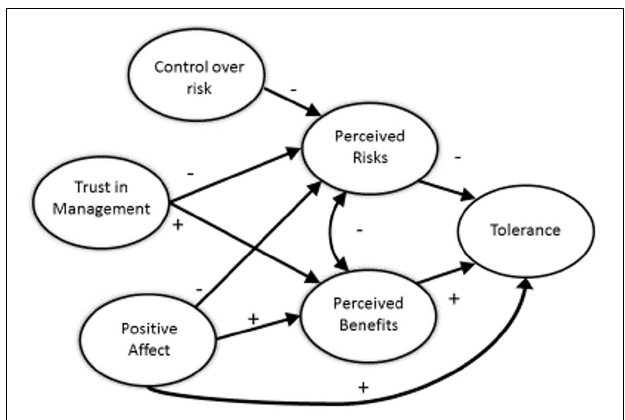
FIGURE 1 | Hypothetical hazard acceptance model, with signs indicating direction of